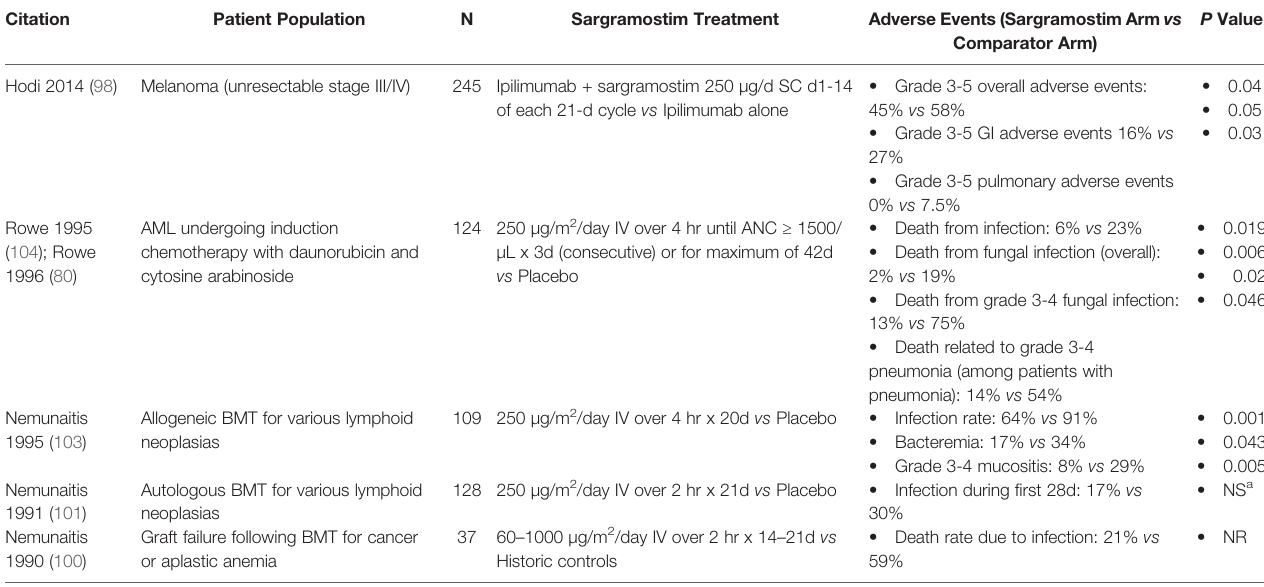
a Only 3.1% of sargramostim-treated patients had infections other than with streptococcus compared with 19.0% of placebo patients (P = 0.004). On the sargramostim arm the only bacterial infection was streptococcal bacteremia, whereas multiple pathogens (streptococcal, staphylococcal, fuso-bacterium and Corynebacterium bacteremia; staphylococcal cellulitis; legionella pneumonia) were detected in patients on the placebo arm. AML,acutemyelogenousleukemia;ANC,absoluteneutrophilcount;BMT, bonemarrowtransplantation;d, day(s);GI,gastrointestinal;hr,hour;IV,intravenous;NR,not reported;NS,not signi fi cant; SC,